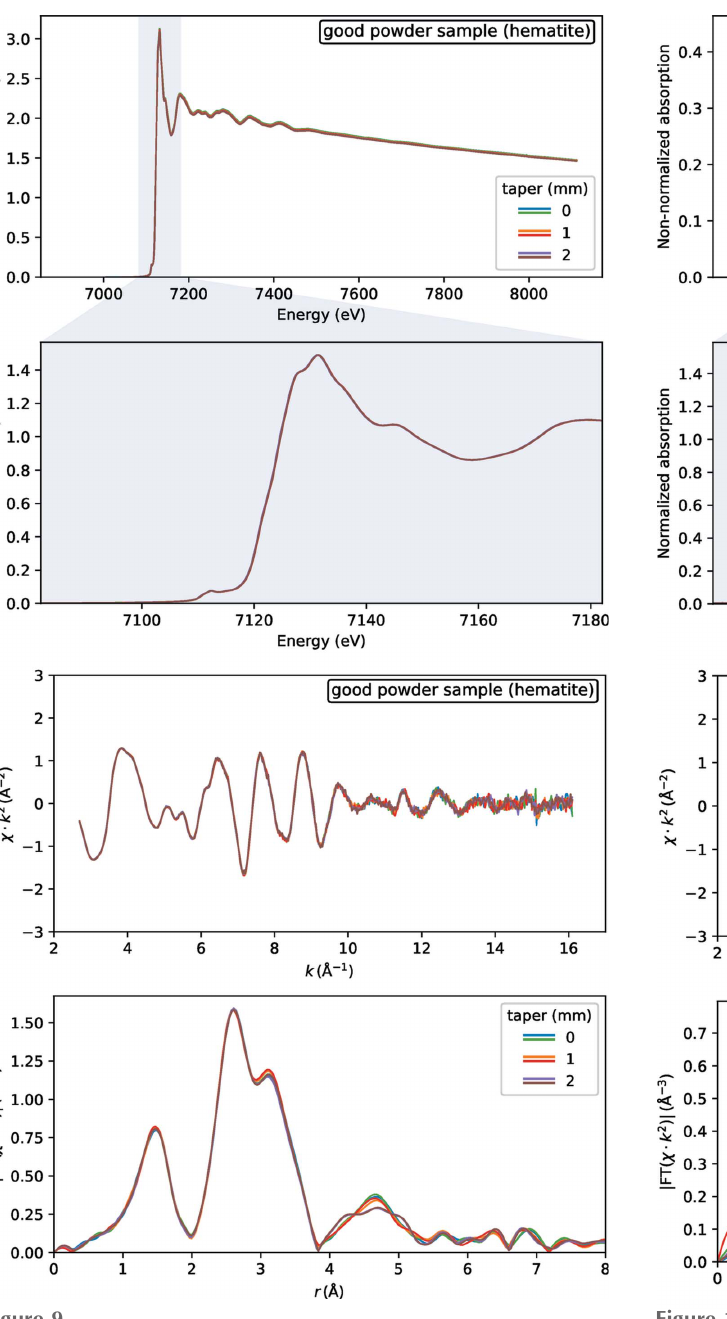
Figure 9 EXAFS spectra for a sample with a fairly homogeneous thickness: a high- quality pressed pellet. Three values of wiggler gap taper were tested, each with two repeats of EXAFS, six curves in total in each plot.